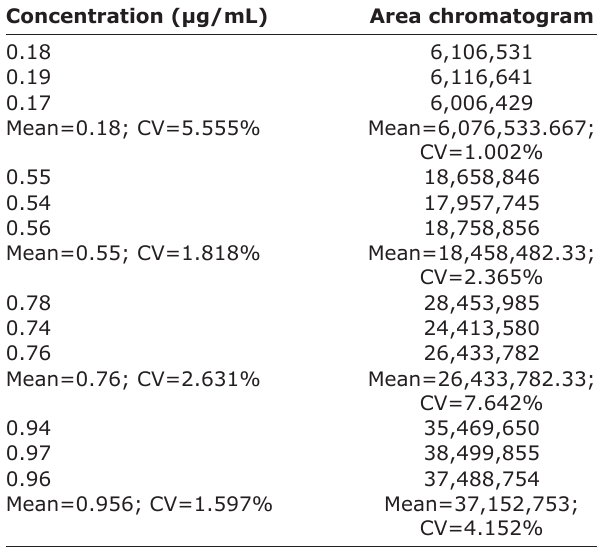
Table-1: The intraday precision of aflatoxin B in mobile phase. Concentration (µg/mL)